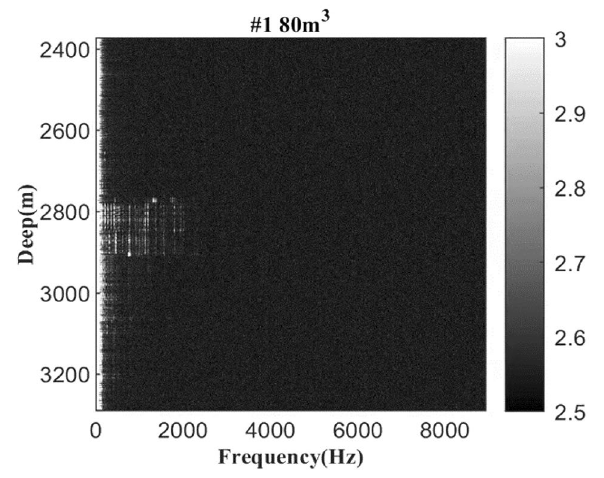
Fig. 5 #1 Waterfall